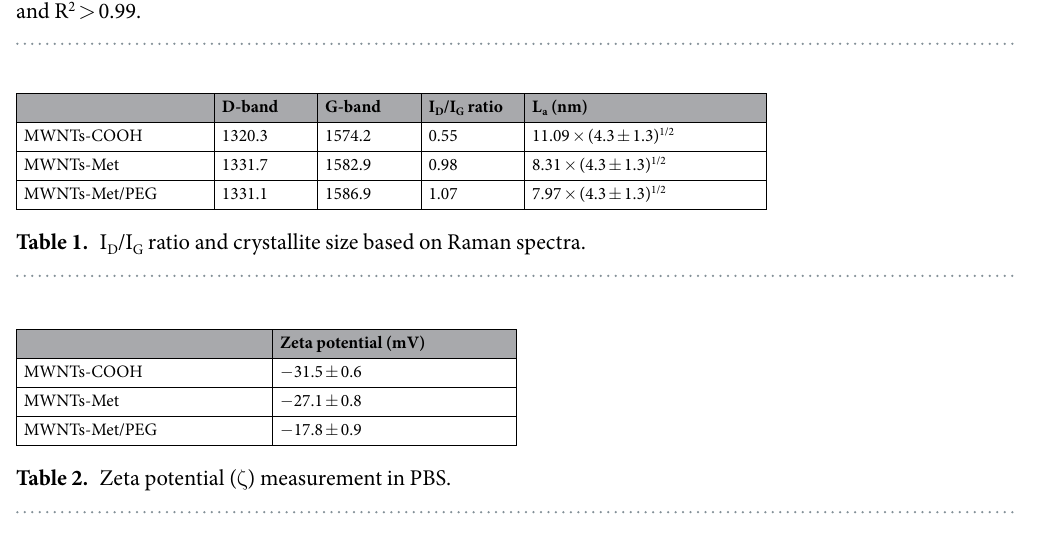
The TEM images (Fig. 2c) show that the nanotubes are coated with PEG, which agree well with the FTIR and Raman results. The MWNTs-Met/PEG was soluble in water (125 µ g·mL − 1 ) and the dispersion remained stable with no precipitation observed after centrifugation for 15 min at 3000 rpm (inset of Fig. 2c). To further interpret the surface modification of MWNTs, ζ potential measurement was carried out (Table 2). MWNTs-COOH shows a negative potential of ( − 31.5 ± 0.6 mV) due to the presence of negative charged carboxyl groups. Meanwhile, MWNTs-Met shows a decreased ζ potential of − 27.1 ± 0.8 mV as the result of metformin grafting which